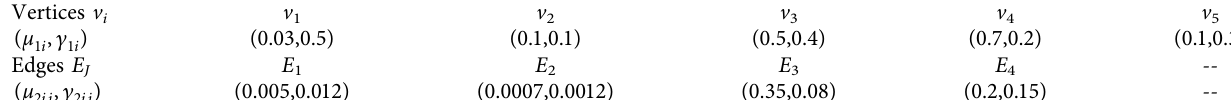
Table 3: Degree of membership and nonmembership values for vertices and edges of Figure 3.